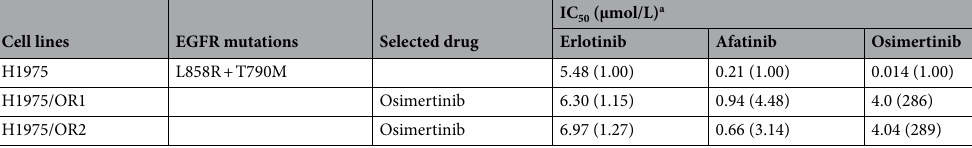
50 value divided by the IC 50 value of the parental cells, is shown in